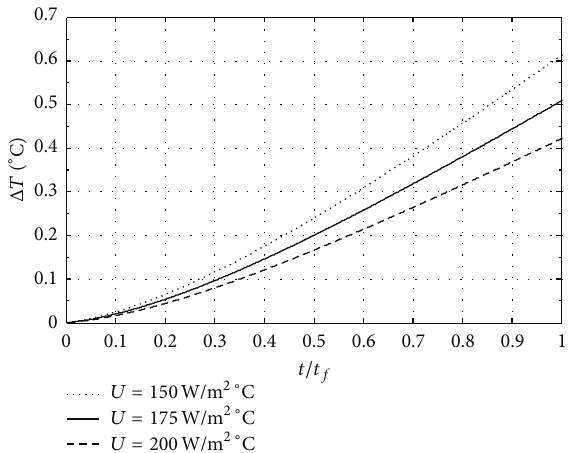
Figure 2: Temperature sensitivity resulting from variations in 𝑈 .